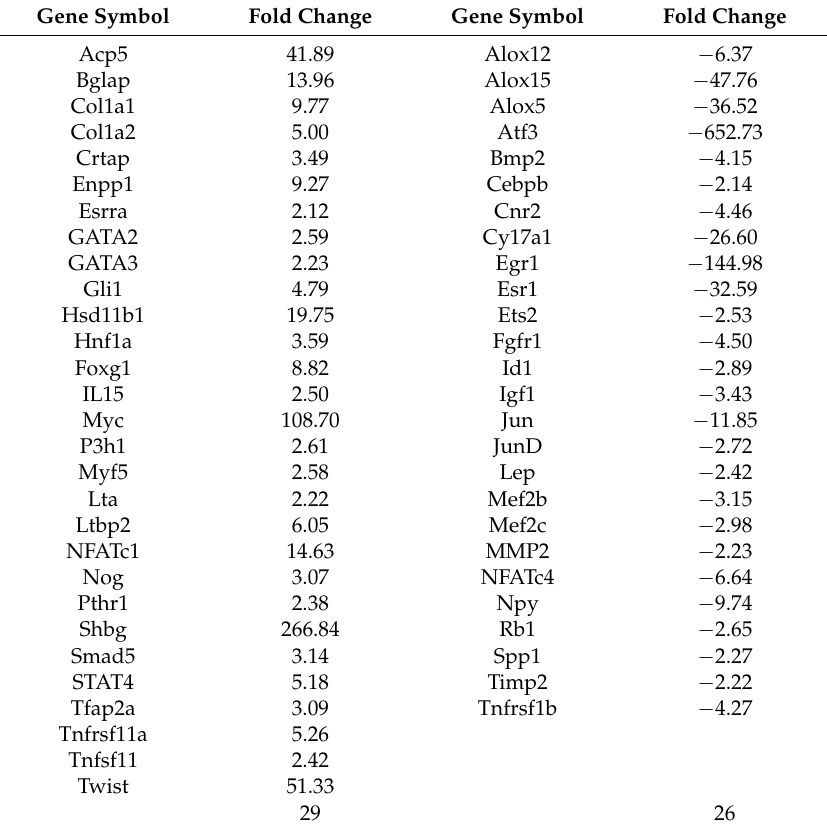
Table 1. List of genes from untransfected RAW 264.7 cells (genes ≥ 2-fold). Gene